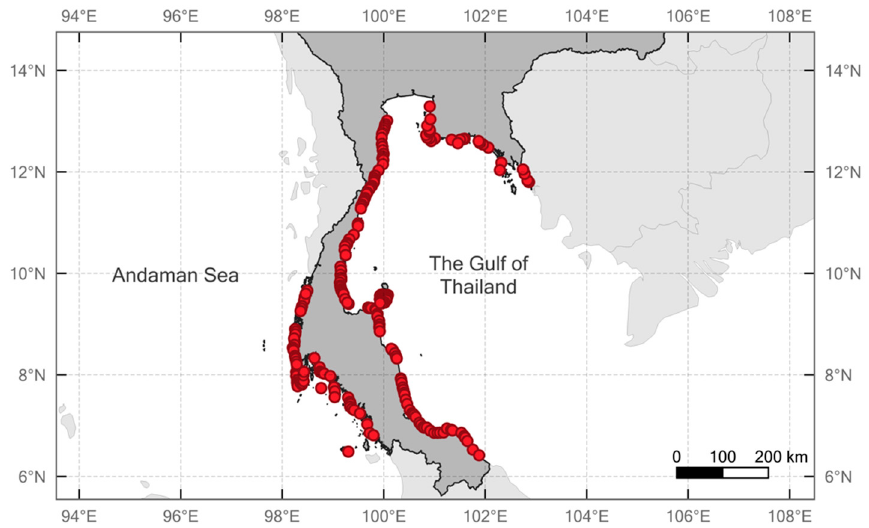
Figure 1. The study area of Thailand. The red signs represent the field measurement location of sediment size and foreshore slope measurements.